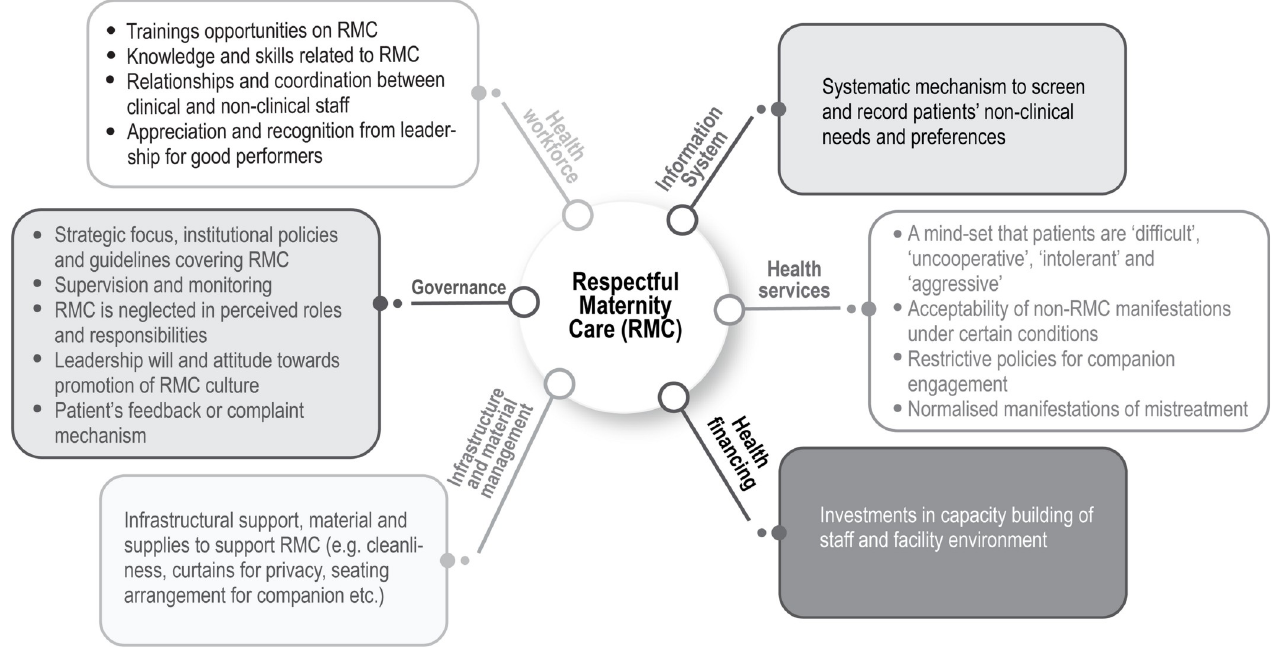
Fig 1. Summary of health systems bottlenecks of respectful maternity